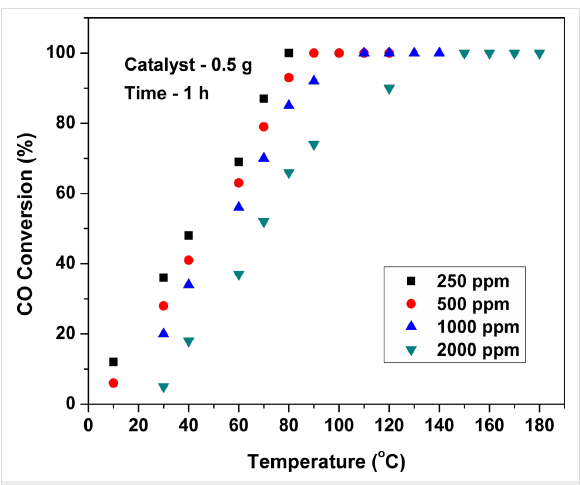
Figure 11: Influence of the initial CO concentration on the CO conver- sion over Pt(1%)-ZrO 2